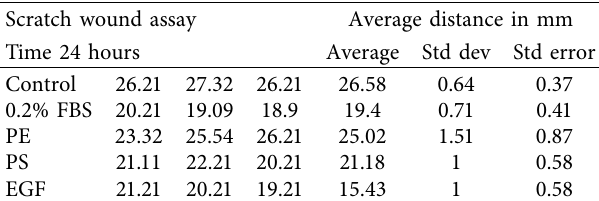
Figure 9: Scratch wound assay for 24 hours and 48 hours. Table 3: Scratch wound assay for 24